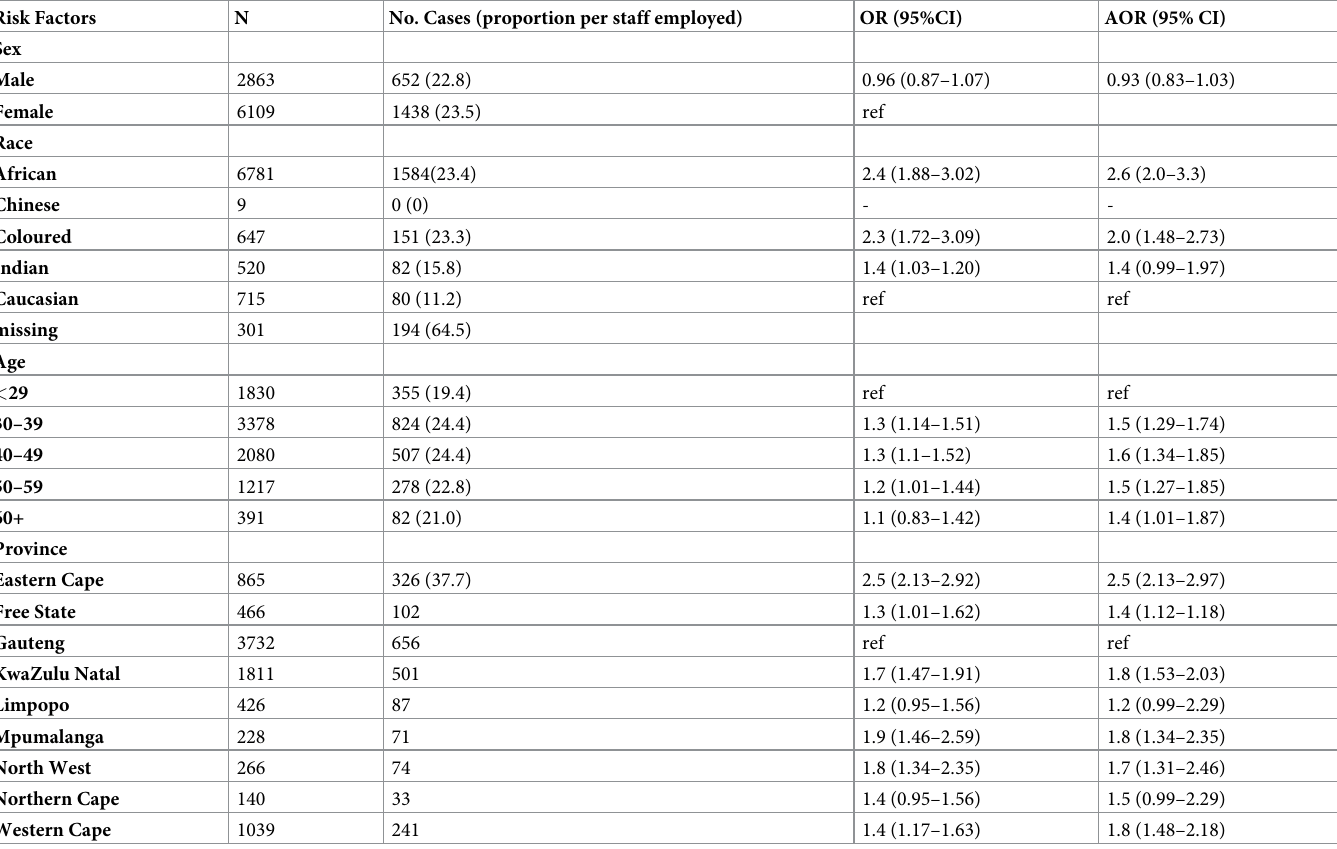
Table 1. Description of the medical laboratory staff included in this analysis 2020–21.